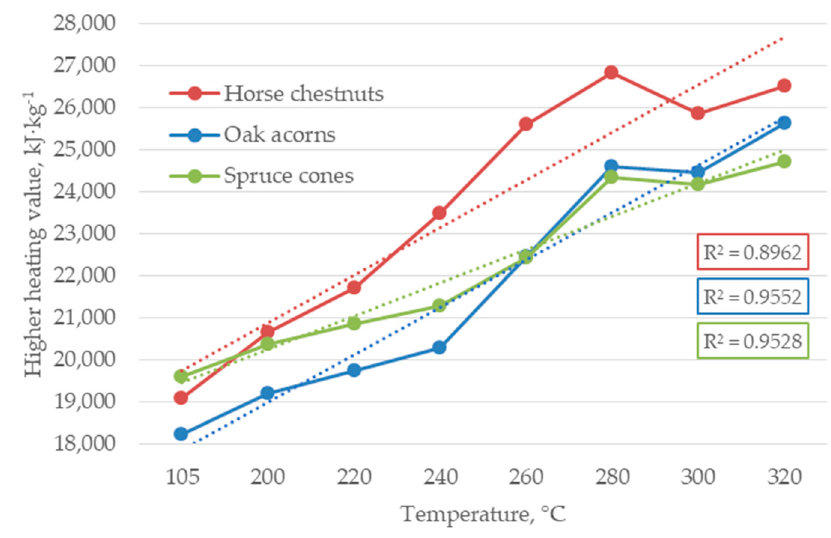
Figure 9. Higher heating value of the torrefied horse chestnuts, oak acorns, and spruce cones.